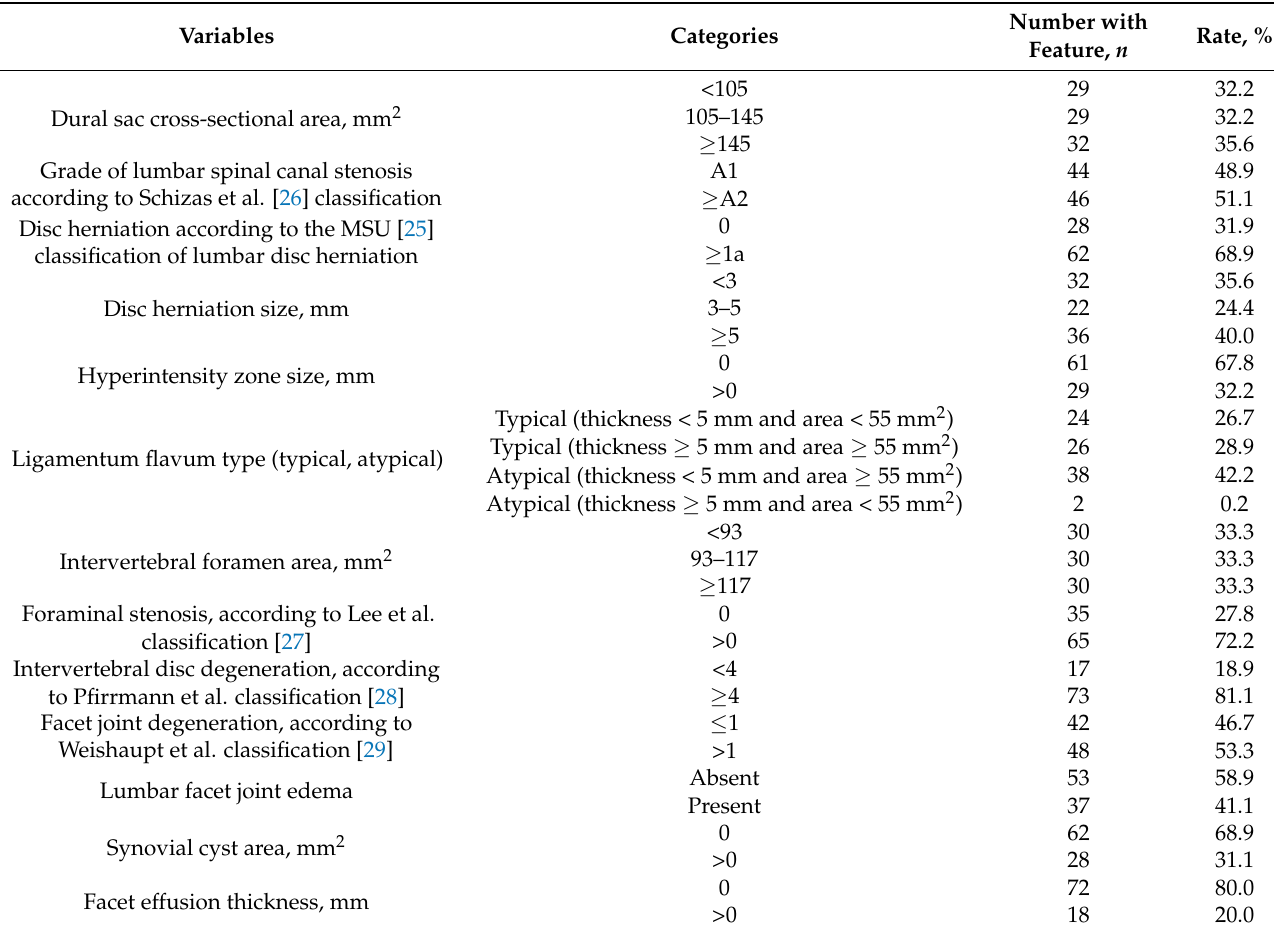
Table 4. Categories and frequencies of variables obtained by axially loaded MRI included in the logistical regression model.